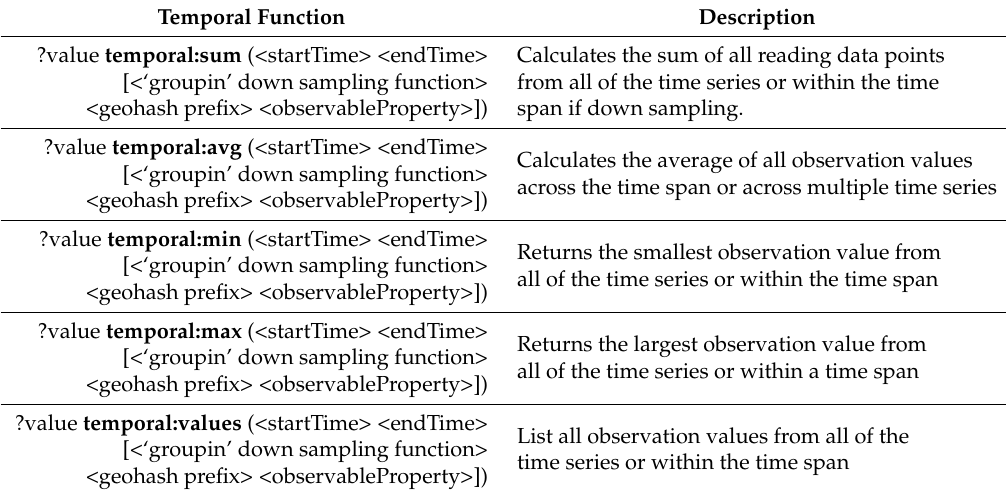
Table 4. Temporal property